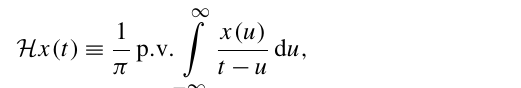
where H is the Hilbert transform operator defined as 1 H x(t) ≡ p . v π